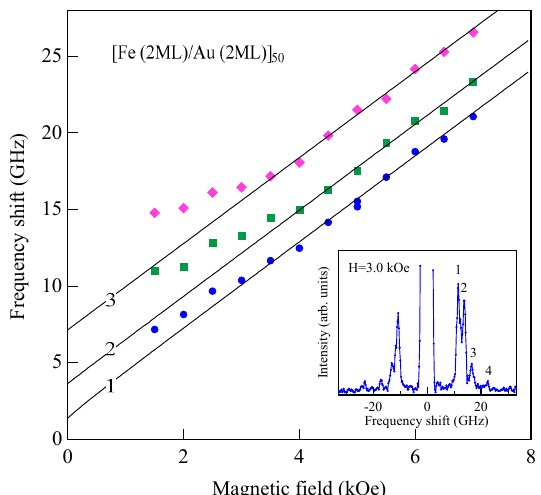
Figure 28. Magnetic field dependence of the SW frequencies for the (2) 50 FLSL. The inset shows the BLS spectrum from the (2) 50 FLSL at H = 3.0 kOe. The solid lines were calculated for the SSWs by using Equations (166) and (167) with the magnetic constants γ /2 π = 2.8 GHz/kOe ( g = 2.0), 4 π M eff = 0.75 kG, and D ⊥ = 2.4 × 10 − 10 Oe·cm 2 [94].